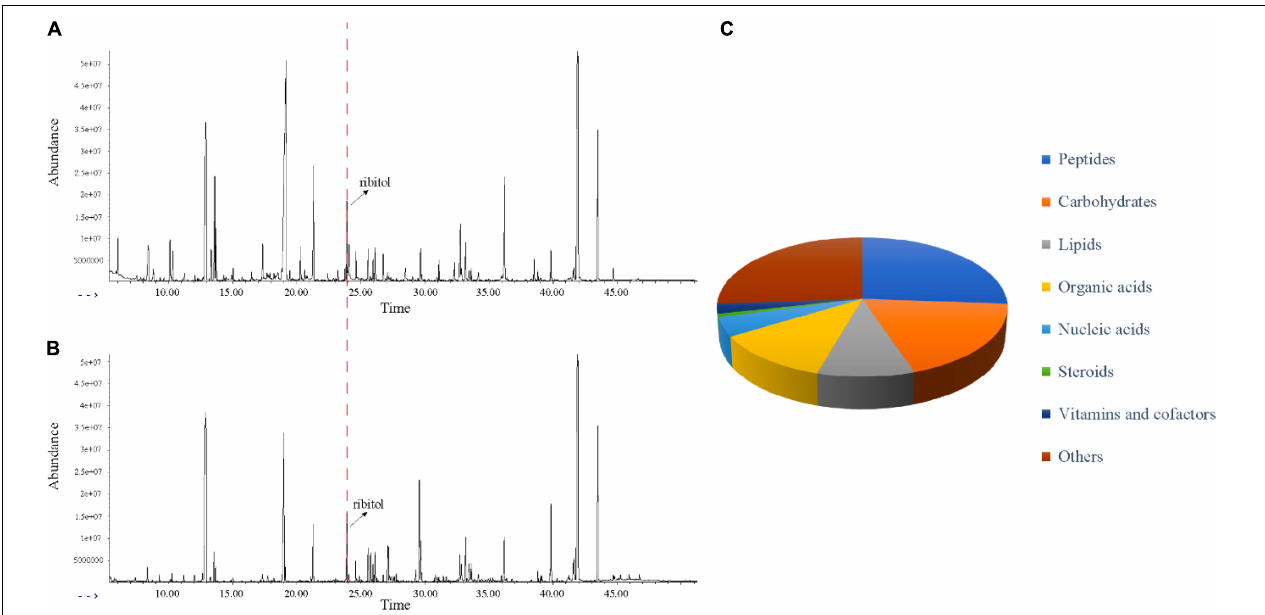
FIGURE 3 | Metabolic profiling of C. acnes before and after EO treated. (A) Typical total ion chromatograms of the metabolic profiles of C. acnes with solvent (Control). (B) Typical total ion chromatograms of the metabolic profiles of C. acnes with EO (MIC). (A,B) Peaks were aligned and internal standard (ribitol) was highlighted. (C) KEGG analysis showed different types of metabolites